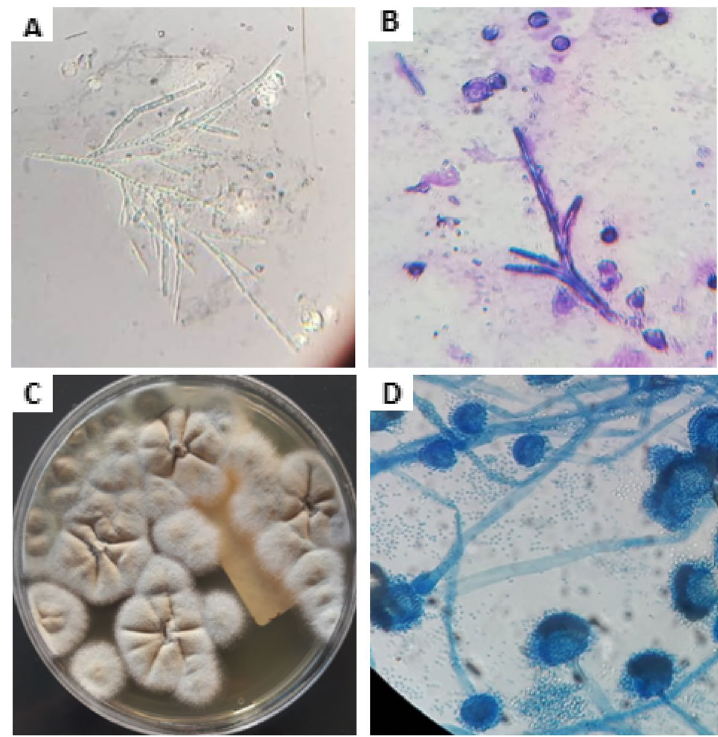
Fig. 3 Direct examination of the subcutaneous collection content, both unstained (A.4: magnification (B.4: magnification 1000), shows large, septated, irregular fungal hyphae with acute angle branching. (C.4): On SC, pure, wrinkled, × whitish-green-colored colonies developed after 2 days of incubation at 37 °C. (D.4): Lactophenol blue-cotton mount showing conidiophores and